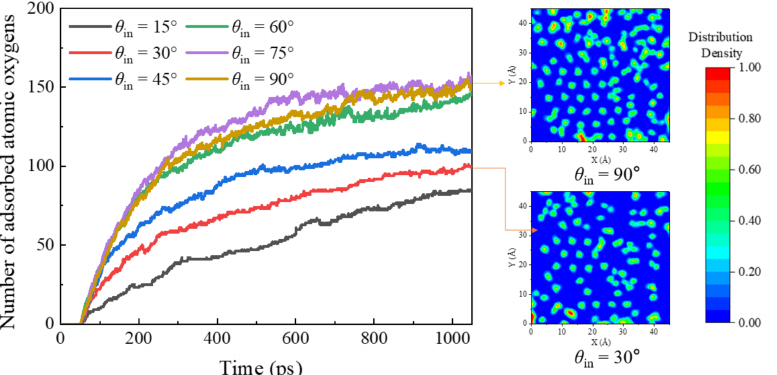
Figure 7. The effect of AO incident angle on the surface adsorption situation with snapshot illustra- tions of the saturated silicon dioxide surface by Models 1 and II-5–9.